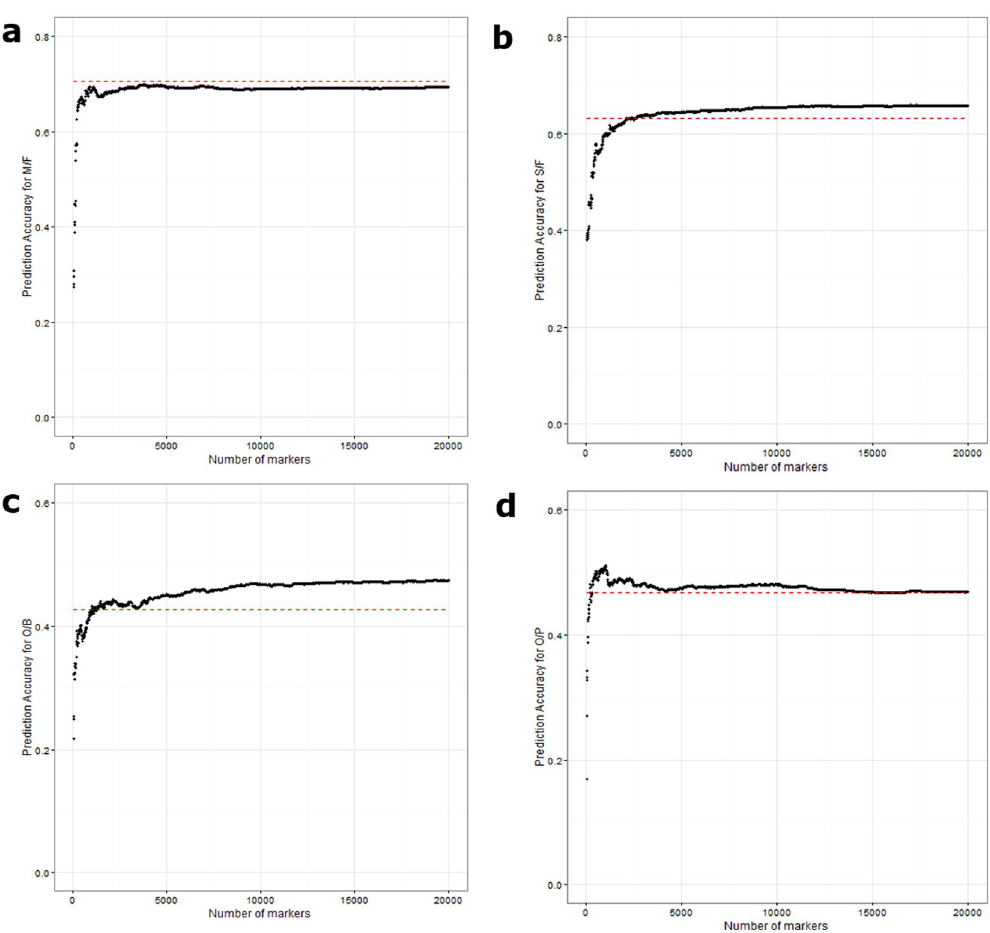
Figure 4. Average prediction accuracy for 4 traits across different marker densities using RRBLUP-B method: ( a ) M/F, ( b ) S/F, ( c ) O/B and ( d ) O/P. ( a ) RRBLUP-B result for M/F with accuracy 0.7 at 3,800 markers (RRBLUP 0.71), ( b ) for S/F with accuracy 0.66 at 10,530 markers (RRBLUP 0.63), ( c ) for O/B with accuracy 0.48 at 12,500 markers (RRBLUP 0.43) and ( d ) for O/P with accuracy 0.51 at 990 markers (RRBLUP 0.47). The red dotted line represents accuracy acquired from RR-BLUP for each